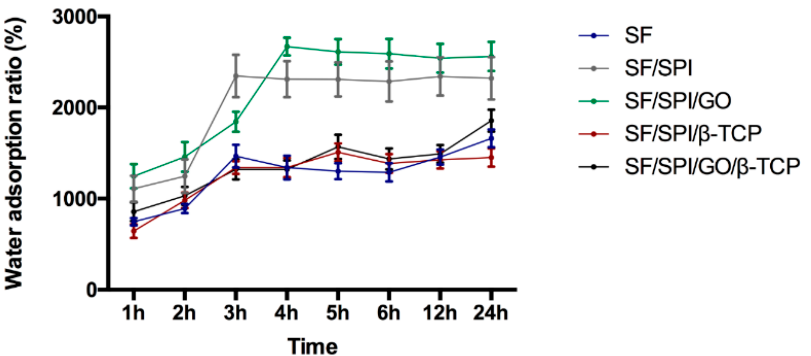
Figure 6. Water adsorption behaviors of the SF/SPI-based composite scaffolds in 24 h.